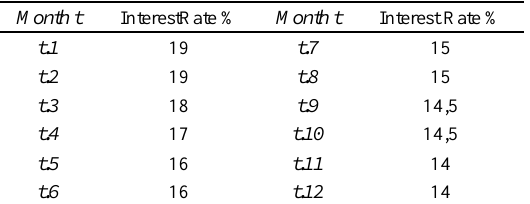
Table 2. Interest rate estimates (monthly time series t)